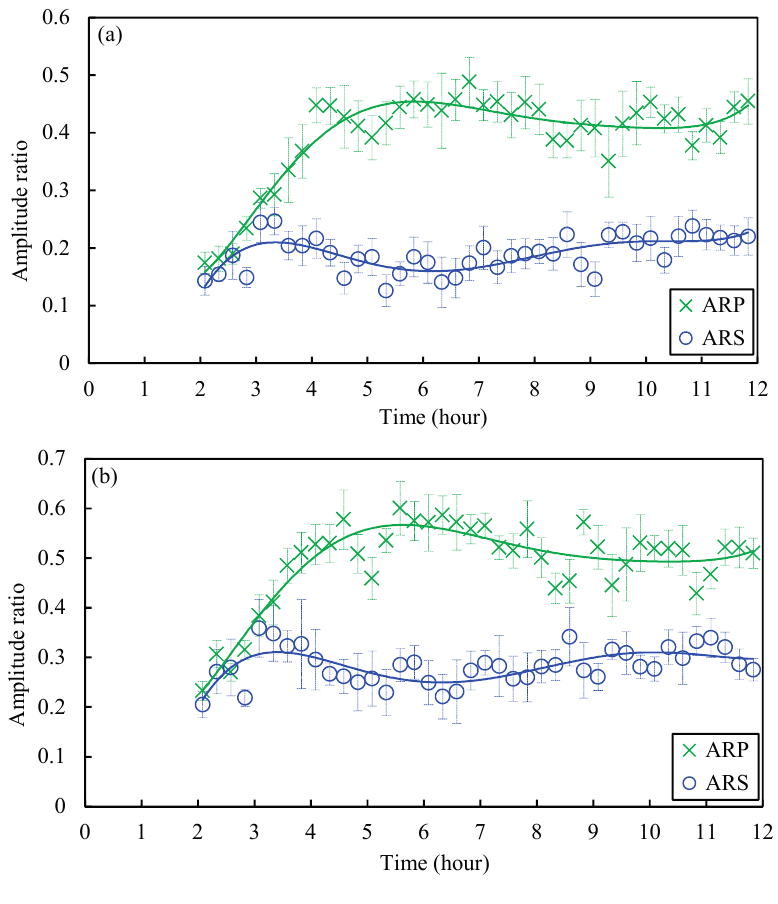
Figure 8. Experimental results of amplitude ratio of PSW (ARP) and SSW (ARS) as a function of time measured from the ( a ) 11th and ( b ) 16th bead in the HNSW